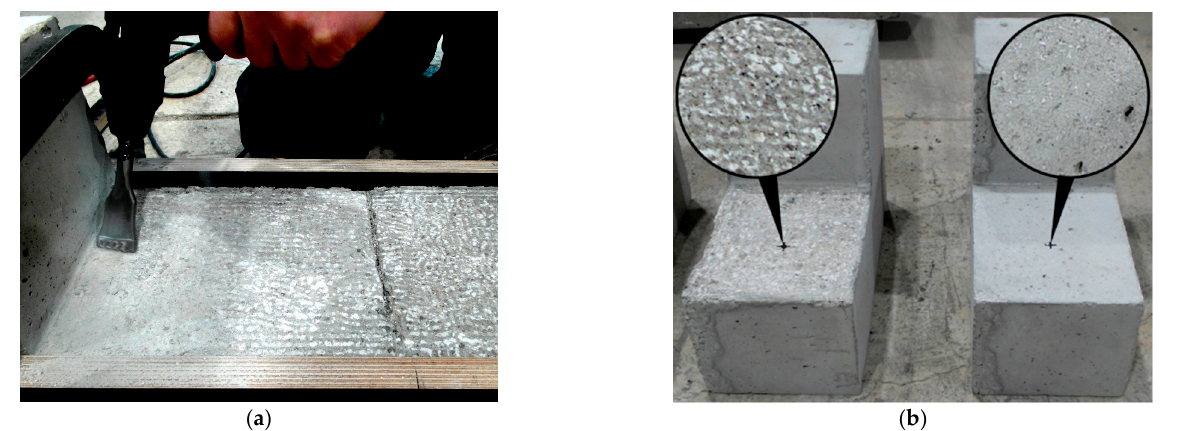
Figure 8. Surface preparation: ( a ) Milling with a chisel, ( b ) view after by milling and soft grinding.